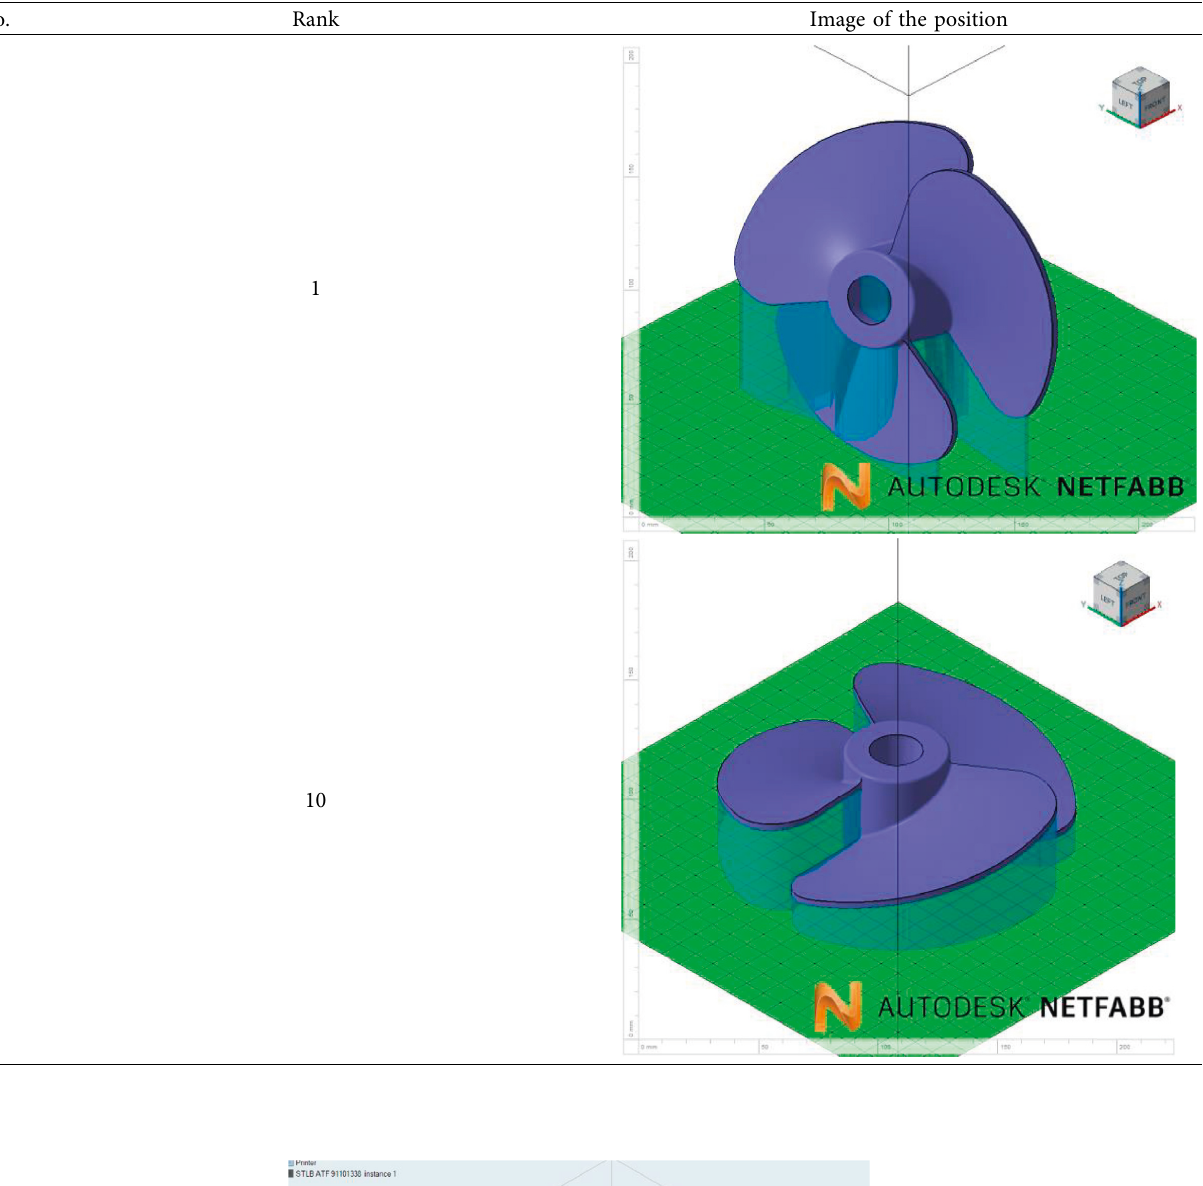
Table 5: Top- and Bottom-ranked positions of 3-blade propeller.